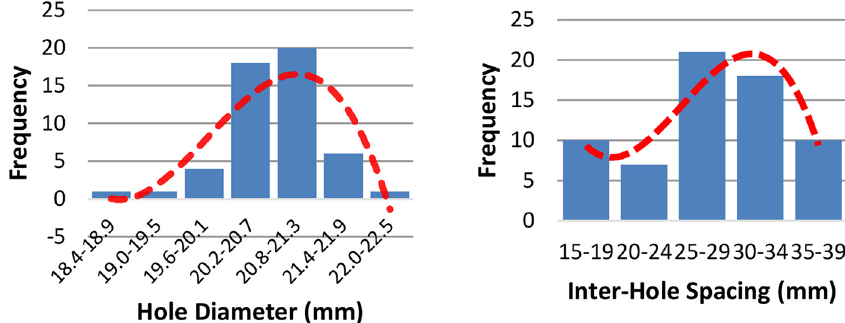
Fig. 3. Frequency curves of ceramic liner-hole diameter and inter-hole spacing.